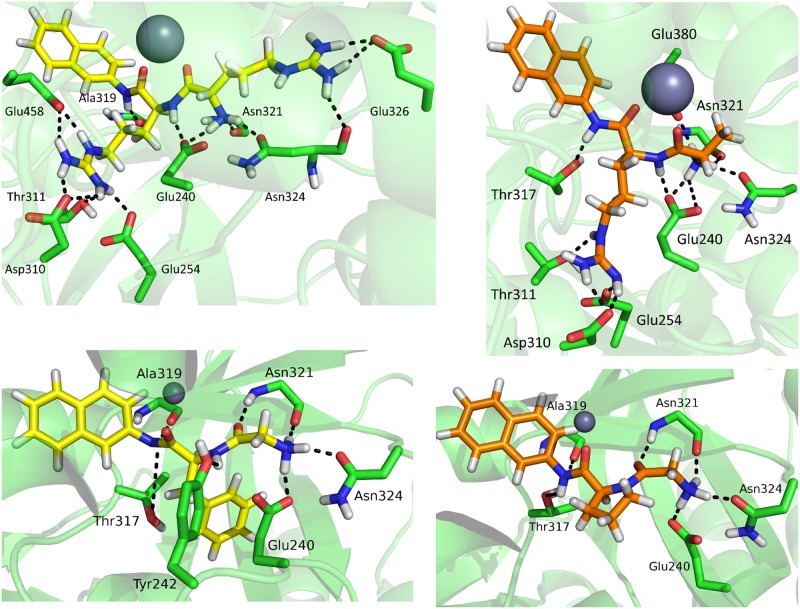
Interactions between substrates, Arg2-2NA (up, left), Gly-Arg-2NA (up, right), Gly-Phe-2NA (down, left) and Gly-Pro-2NA (down, right) and the amino acid residues from the CaDPP III active site.The figure was prepared using the PyMol program [51].